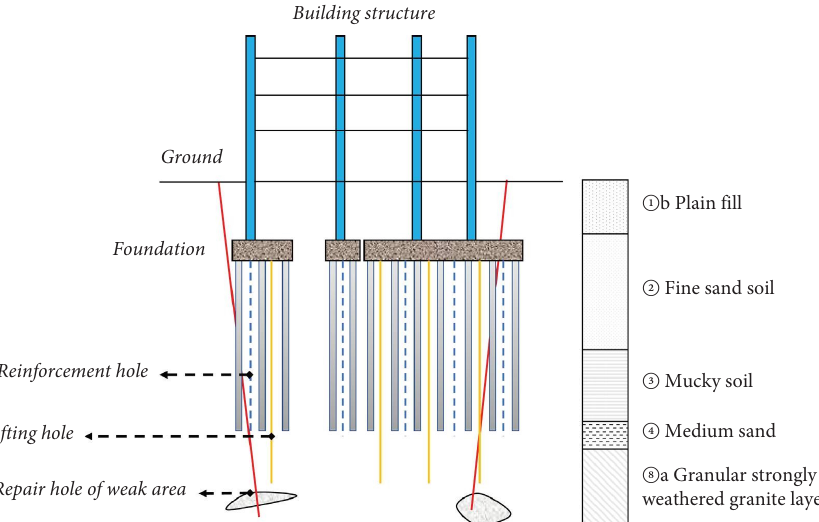
Figure 3: Layout of grout